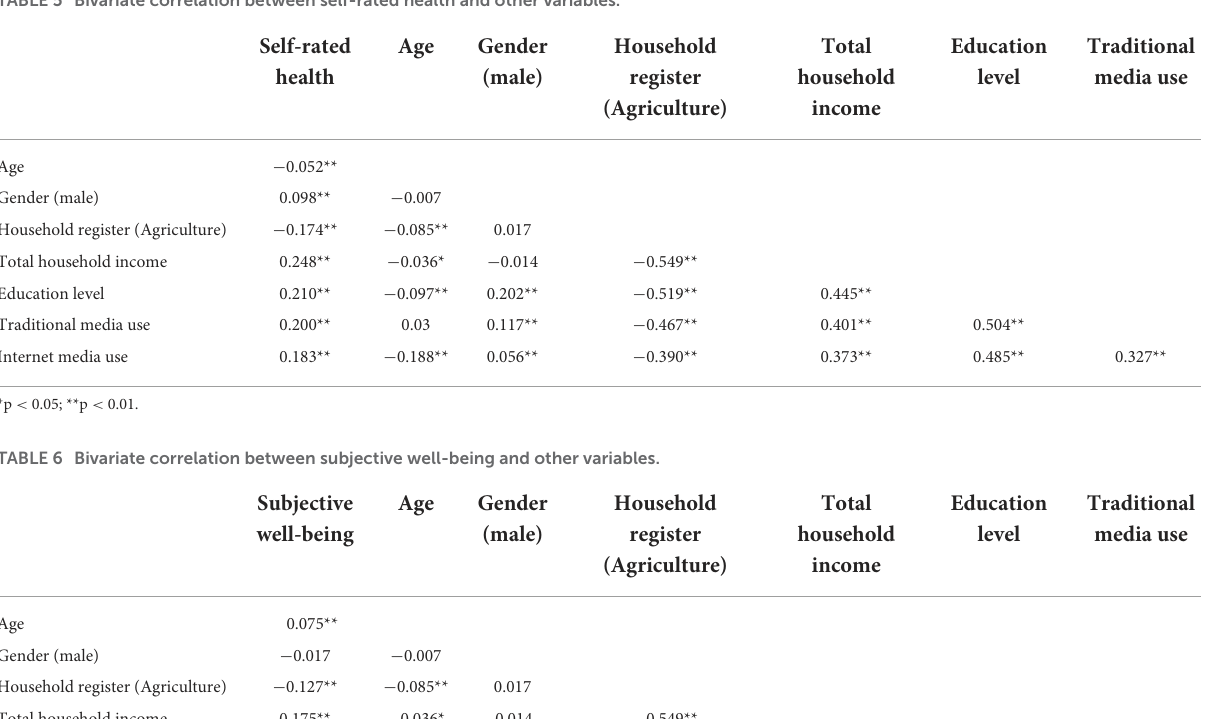
TABLE 5 Bivariate correlation between self-rated health and other variables.